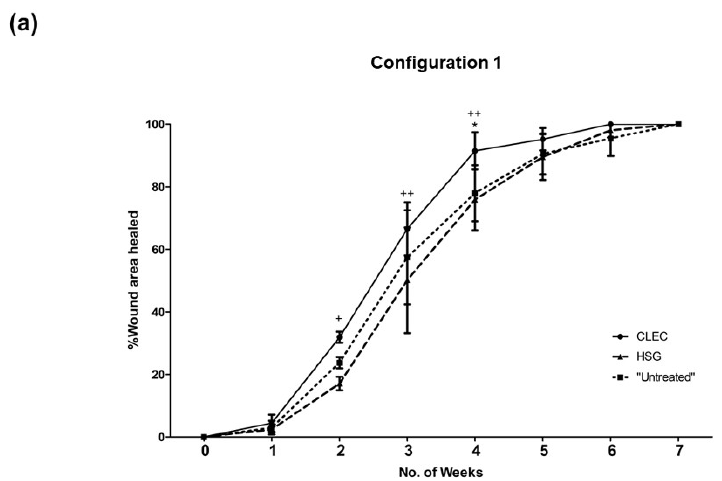
Table 1. Location and distribution of markers associated with human skin epidermis, basement membrane, and epidermal stem cells within the entire epithelia reconstituted by KCs or CLECs in organotypic cultures.